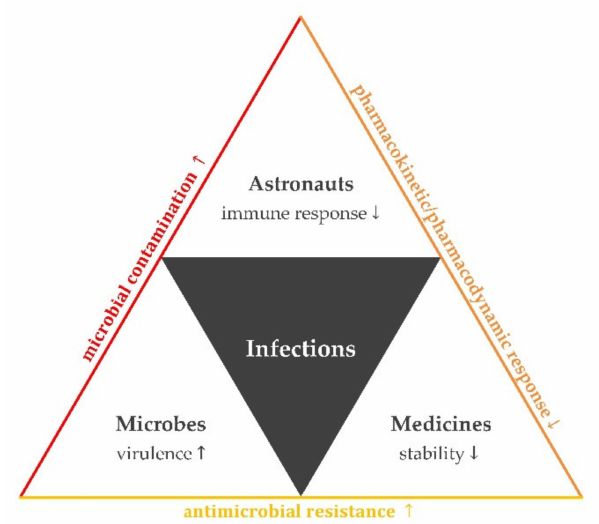
Figure 1. Factors that could enhance the risk of infections and their transmission in the spaceflight en- vironment. Alterations in astronauts’ microbial flora and bacterial physiology could lead to increased microbial contamination onboard. Changes in astronauts’ physiology as well as in physico-chemical properties of pharmaceuticals could influence pharmacokinetics and/or pharmacodynamics. In- creased microbial virulence and decreased drug susceptibility could enhance antimicrobial resistance. Notations: ↑ increase; ↓